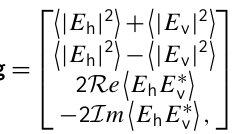
The air–snow interface ( M as ) and snow–ice interface backscattering ( M si ) are modeled using the IEM introduced by Fung and Chen (2004), whereas the volume contribu- tion ( M v ) is calculated using the vector radiative transfer